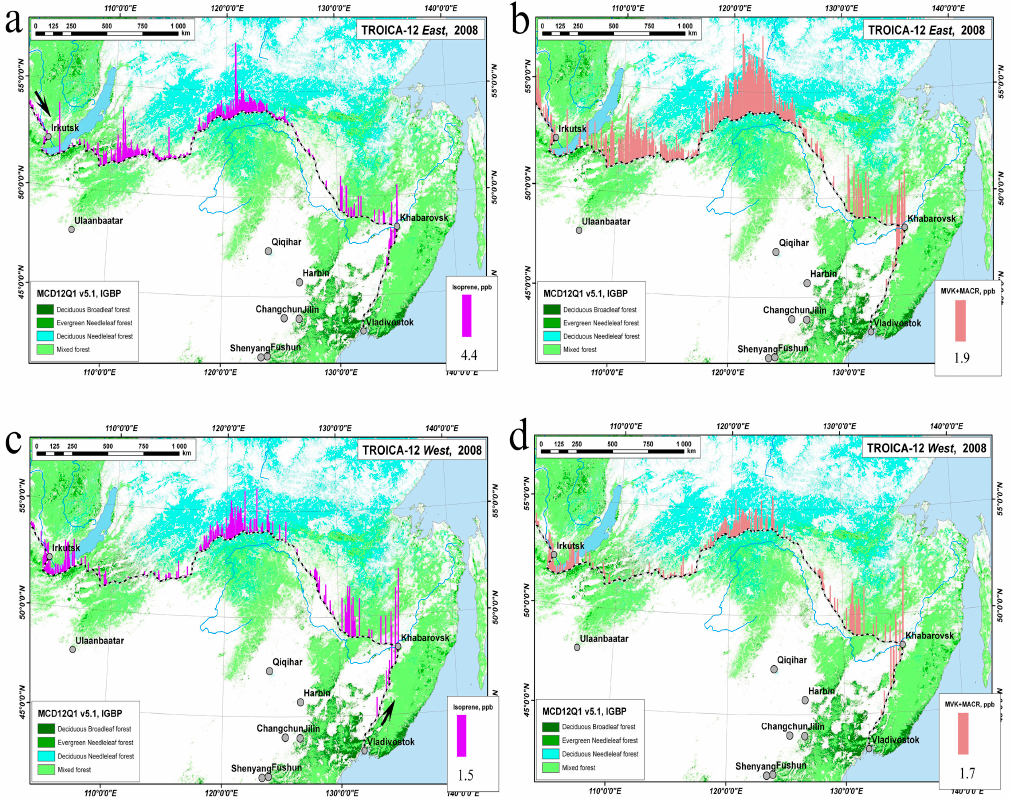
Figure 1. Spatial distribution of isoprene ( a , c ) and methyl vinyl ketone (MVK) + methacrolein (MACR) ( b , d ) along the Trans-Siberian Railway, measured in TROICA-12 East ( a , b ) and West ( c , d ) experiments in July 2008. The MCD12Q1 v5.1, IGBP vegetation map of deciduous broadleaf, needleaf and mixed forest, with a 500 m resolution, obtained from the satellite data MODIS Terra and Aqua, is used as a background map. The arrow notes show the direction of the mobile-laboratory movement.